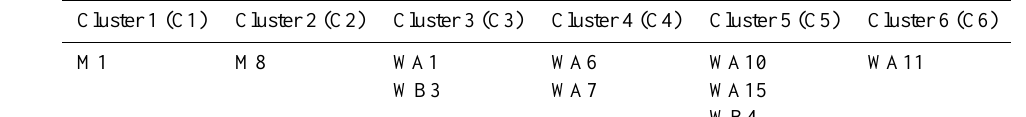
Table 2. Potential clusters for characterizing the patterns of CO 2 efflux in the study area.